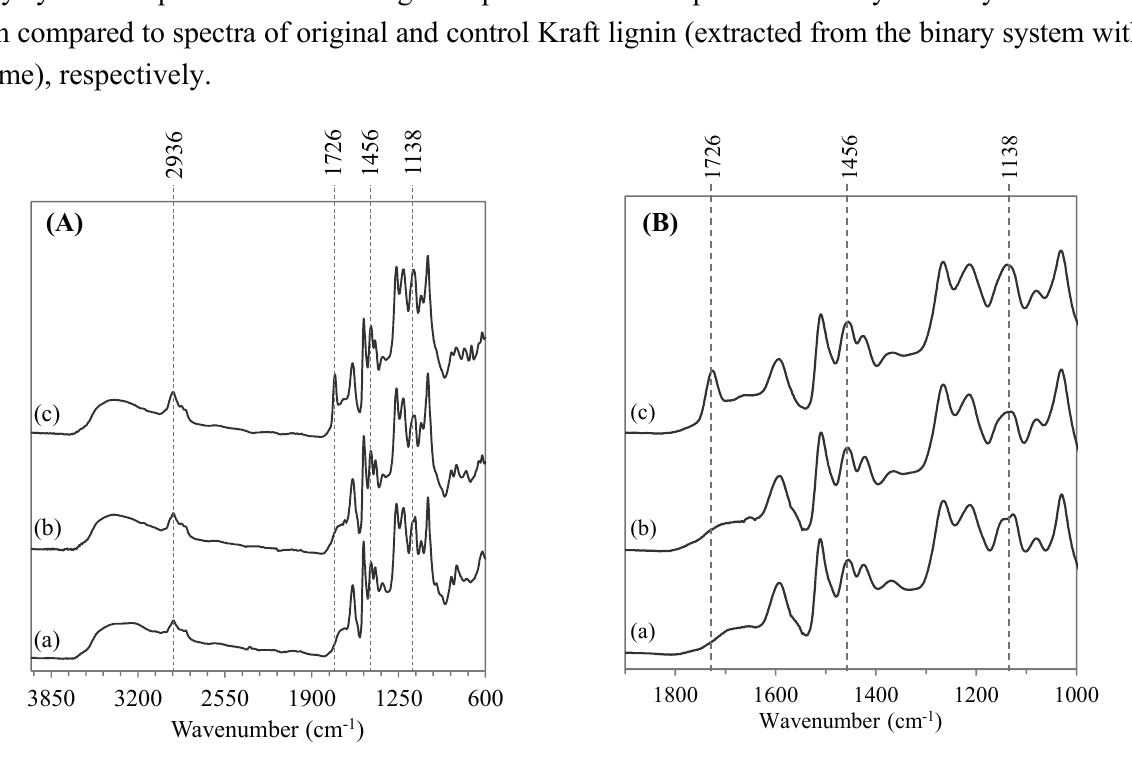
Figure 4. FTIR spectra ( A ) and their respective zooms of region from 1800 to 1000 cm − 1 ( B ) of original Kraft lignin (a), control Kraft lignin extracted from the [C 4 C 1 mim][OTf]/ [C 4 C 1 mim][PF 6 ] binary system without enzyme (b) and lignin oleate extracted from [C 4 C 1 mim][OTf]/[C 4 C 1 mim][PF 6 ] binary system after transesterification catalyzed by the immobilized lipase B from Candida antarctica